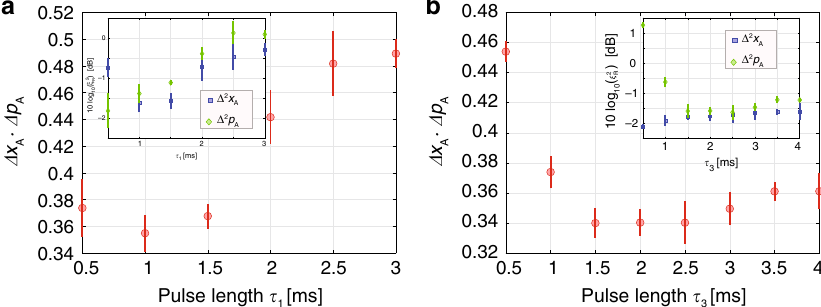
Fig. 2 Experimental results demonstrating “ violation ” of the Heisenberg uncertainty relation. Value of Δ ^ x A (cid:2) Δ ^ p A as a function of ( a ) τ 1 and ( b ) τ 3 are shown respectively. The plotted values are inferred by (4) from the correlations between the optical Faraday rotation measurements. The Heisenberg uncertainty relation is represented by the value 1/2. In ( a ) τ 3 = 2 ms, and in ( b ) τ 1 = 1 ms, and τ 4 = 1ms for both fi gures. The insets show the Wineland Þ in dB units for ^ x 2 squeezing parameter 10log 10 ð ξ 2 and ^ p 2 (See Supplementary Note 7). The error bars (one standard deviation) are derived from 5 R A A identical experiments for Δ ^ x A and Δ ^ p A respectively, each consisting of 10,000 repetitions of the corresponding pulse